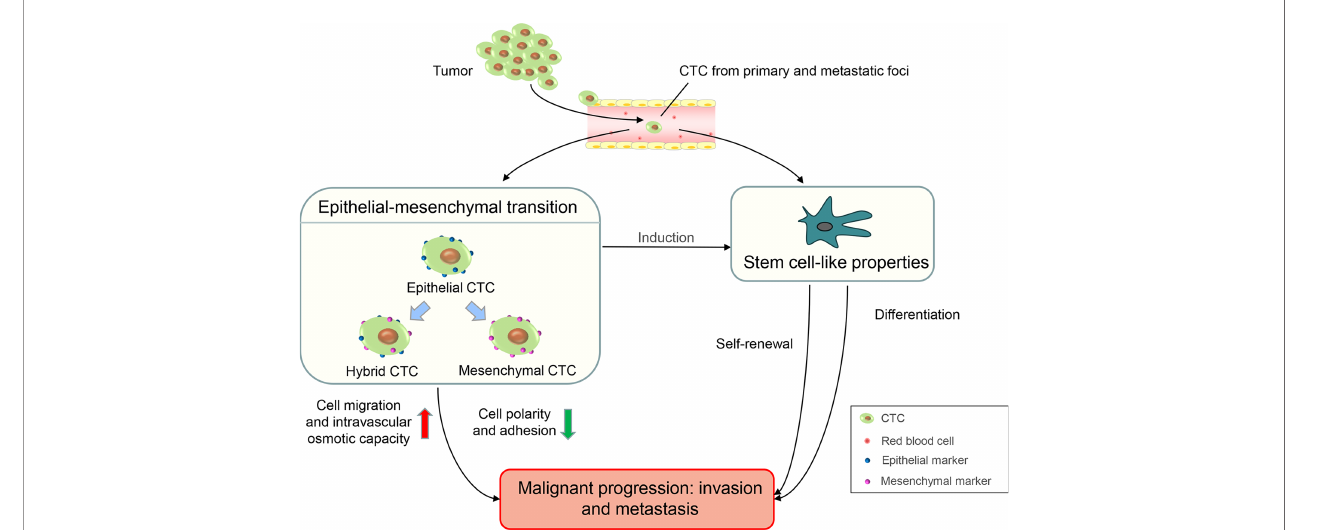
FIGURE 1 | The biological properties of CTCs and their effects on tumors invasion and